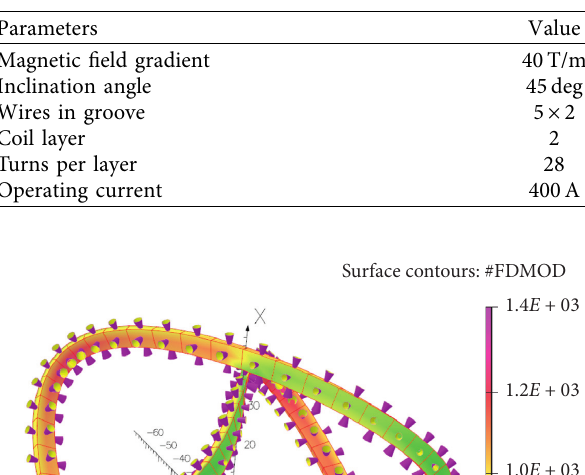
Figure 6: The interpolating process of zero net force for δ assumed values. Table 2: The main parameters of magnets.